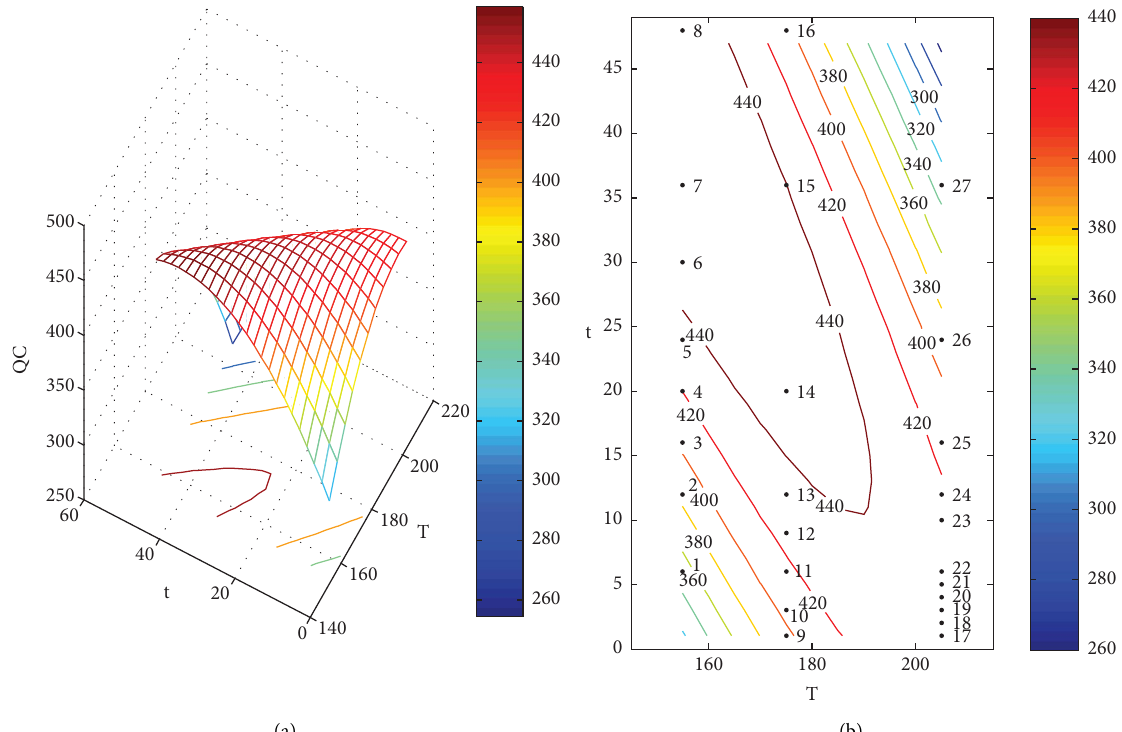
Figure 7: 3D surface graph of the regression model (a) and quality map (b) for Q heat treatment condition.